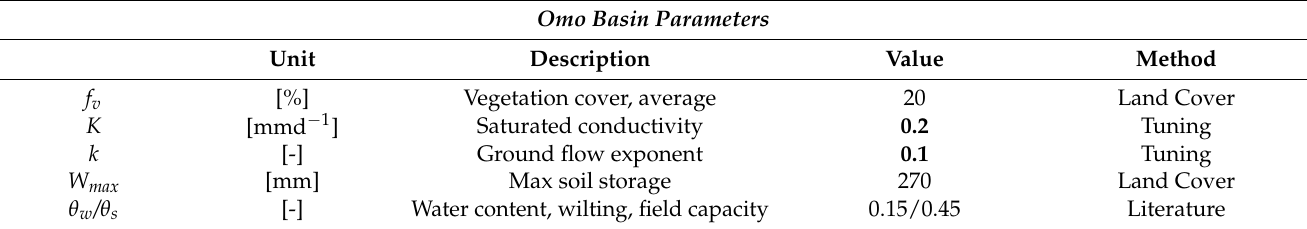
Table 5. Calibration of Poli-Hydro model. Omo river. In bold, values of the calibration parameters. Table 6. Goodness of fit of Poli-Hydro model. Monthly statistics as available.